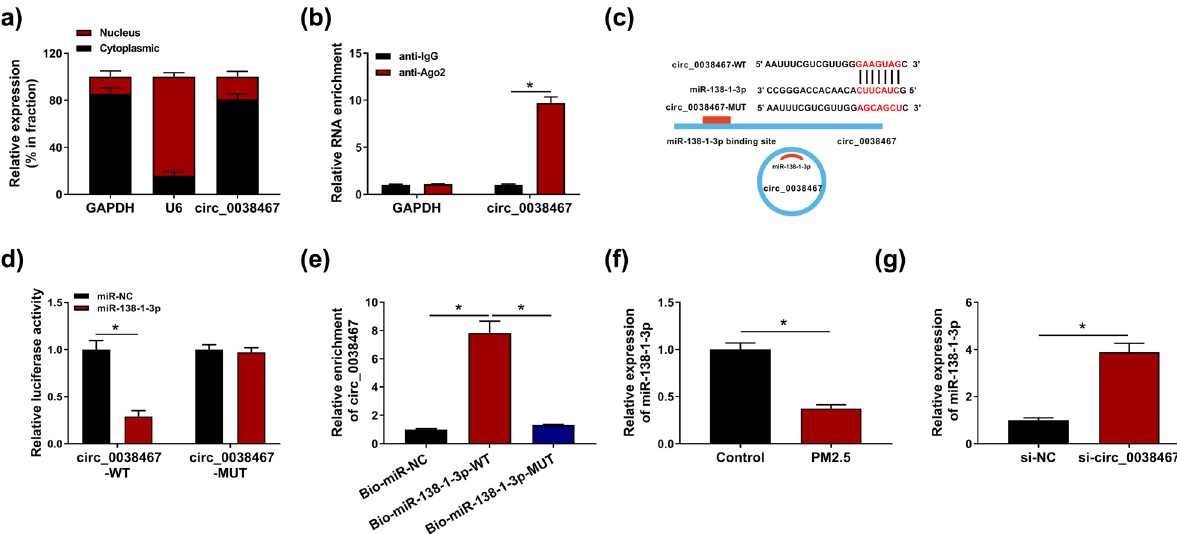
Figure 3: miR - 138 - 1 - 3p was target of circ_0038467. ( a ) circ_0038467 level by RT - qPCR in the nuclear and cytoplasm fractions of BEAS - 2B cells. ( b ) circ_0038467 level by RT - qPCR in BEAS - 2B cells after RIP assay. ( c ) The potential binding sites of circ_0038467 and miR - 138 - 1 - 3p. ( d ) Luciferase activities detection in BEAS - 2B cells co - transfected with the reporter plasmid and the indicated miRNAs using the dual - luciferase reporter assay. ( e ) The enrichment of circ_0038467 by RT - qPCR in BEAS - 2B cells pulled down by Bio - miR - 138 - 1 - 3p. ( f ) RT - qPCR analysis of miR - 138 - 1 - 3p expression in BEAS - 2B cells treated with or without PM2.5. ( g ) RT - qPCR analysis of miR - 138 - 1 - 3p expression in